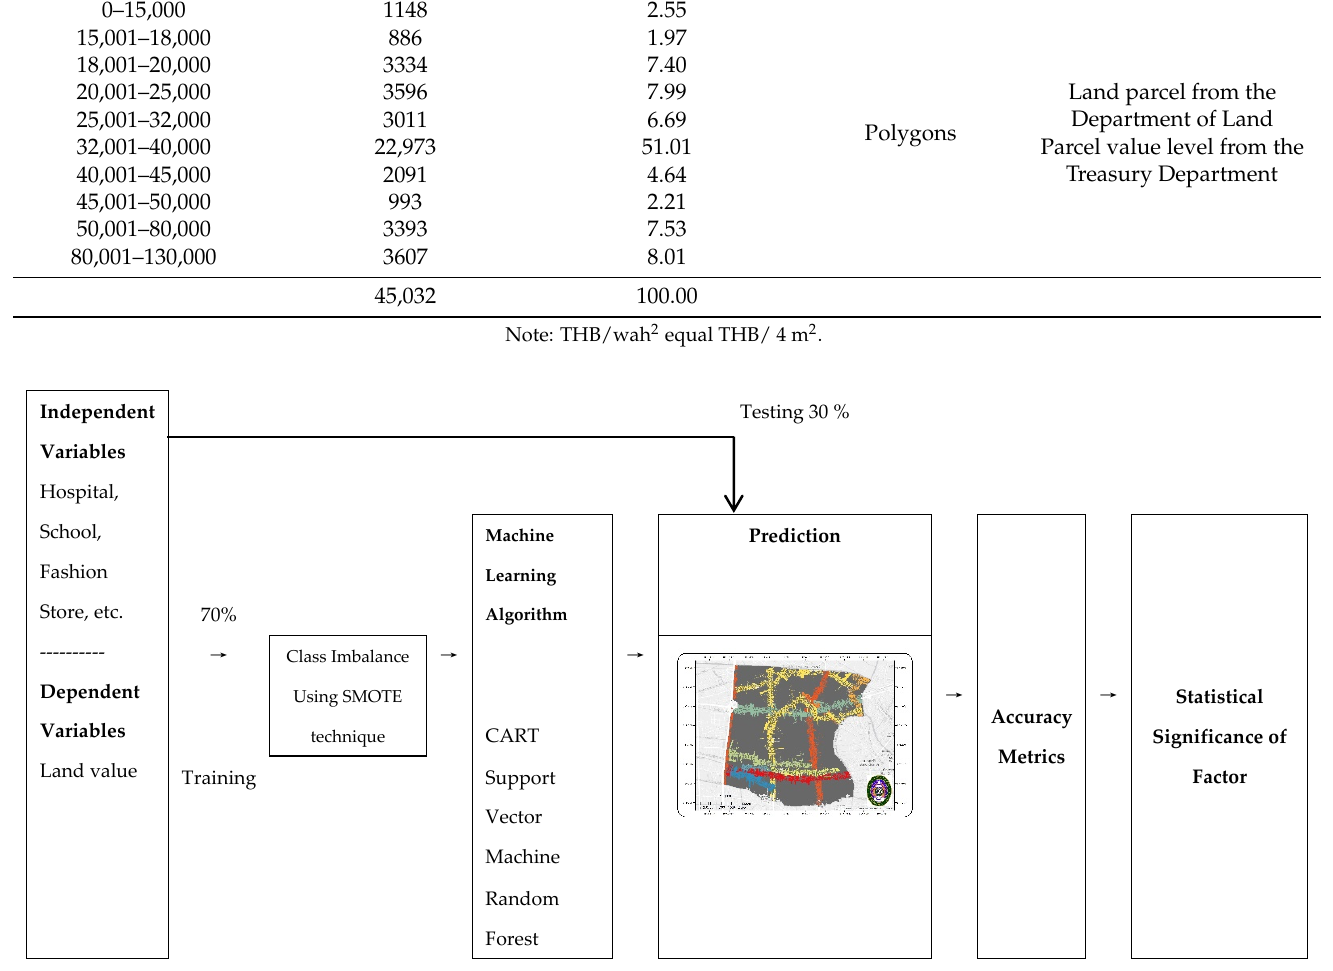
Figure 5. Modeling Framework.